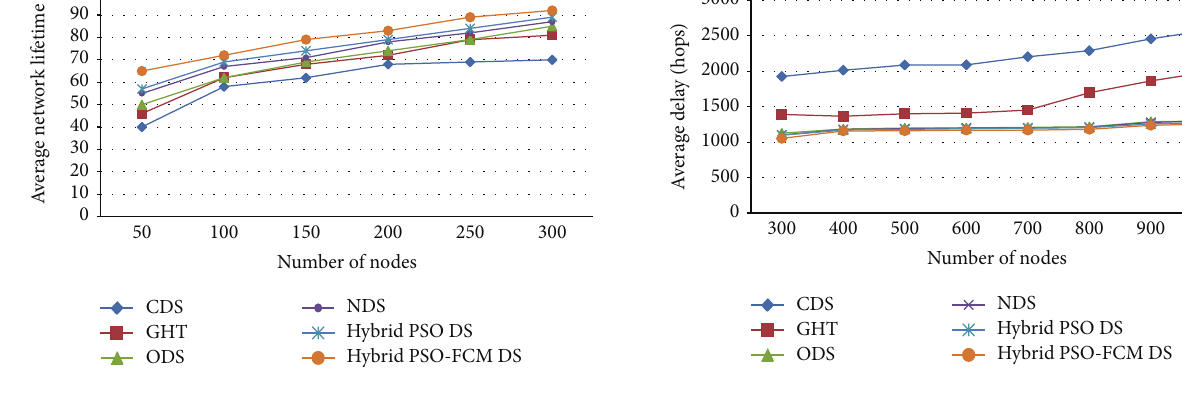
Figure 5: Network lifetime with different number of storage nodes.